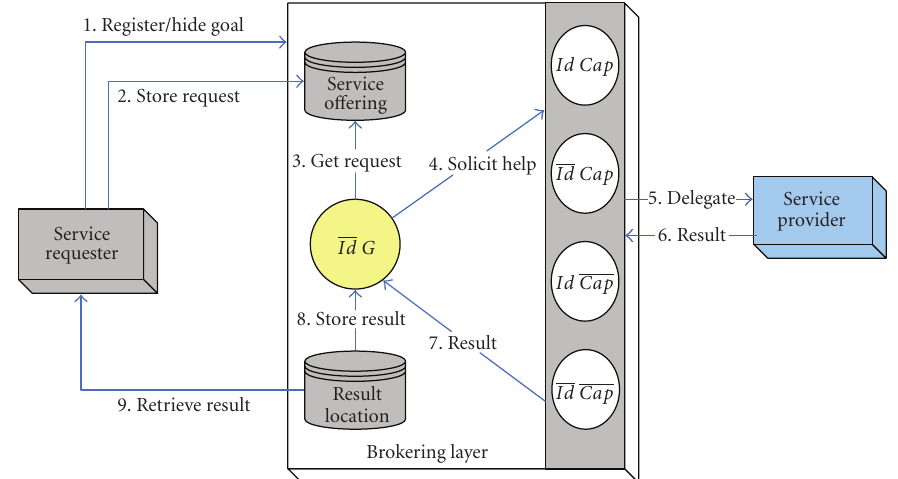
Figure 3: Interaction pattern for requesters hiding